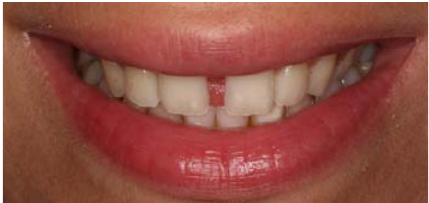
Figure 1: Preoperative extraoral view of the patient with aesthetic problems due to the tongue thrust.